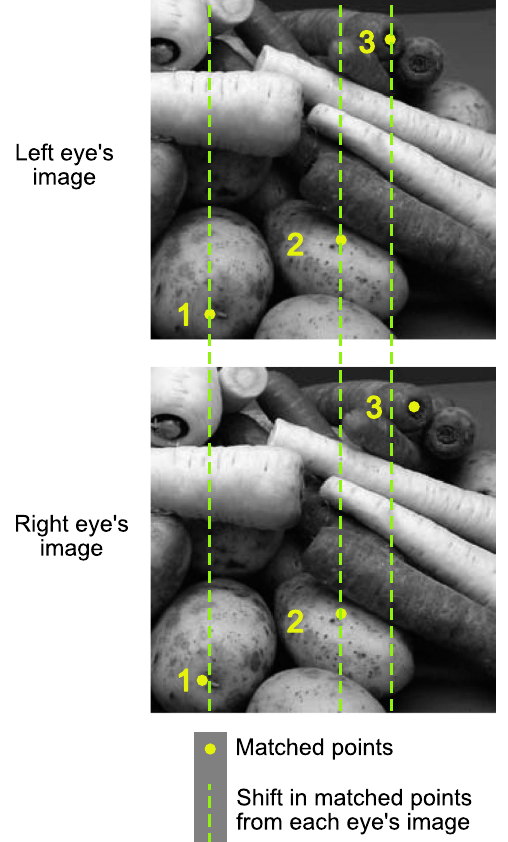
Fig 1. Each eye, the left (top) and right (bottom), receives a different image depending on fixation (point 2). The point of fixation falls on the same retinal location and has zero disparity. For point 1 , there is a small shift leftwards in the right eye’s image in comparison to point 1 in the left eye’s image. This crossed disparity arises as this point in the image is closer than the fixation point. Conversely, there is a rightward shift of point 3 from the left to the right eye’s image. This uncrossed disparity arises as this point is further away than the fixation point. Point 1 will appear closer and 3 further away. Images are drawn from